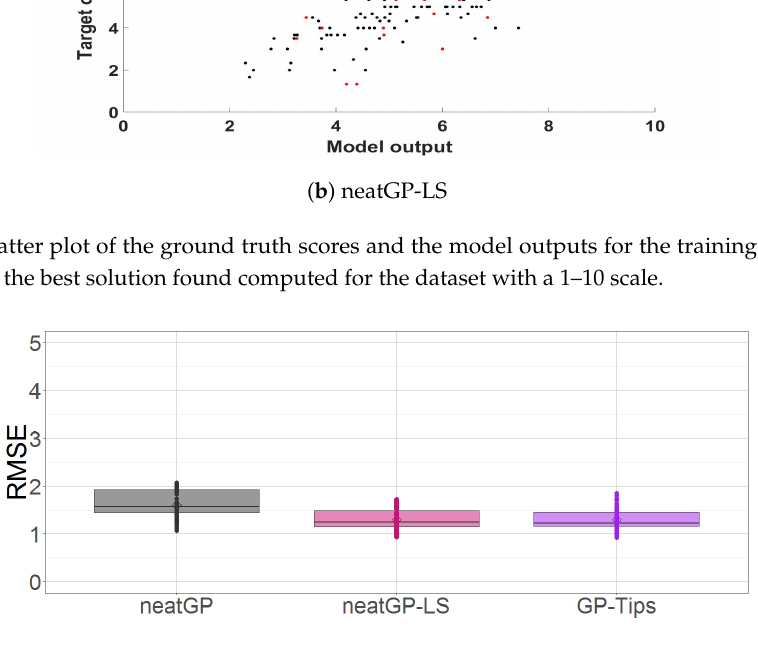
Figure 2. Box plot comparison of all methods based on testing fitness on the dataset with a 1–10 scale. Experiment 2: Targets in scale 1–4. Tables 6–8 summarize the performance of GPTIPS, neatGP and neatGP-LS, respectively.